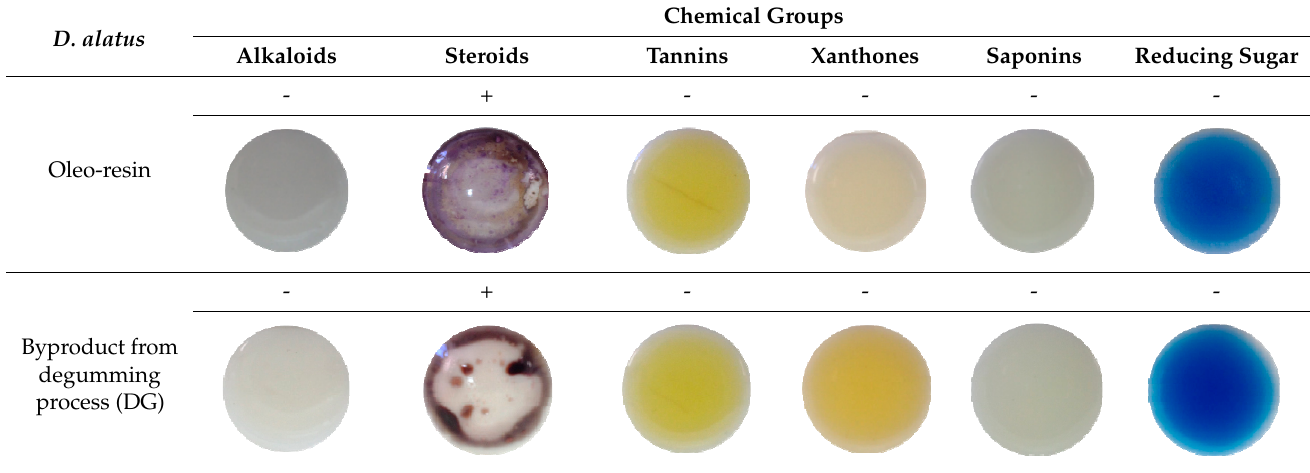
Table 1. Phytochemical screening of oleo-resin and resin from different preparation processes.